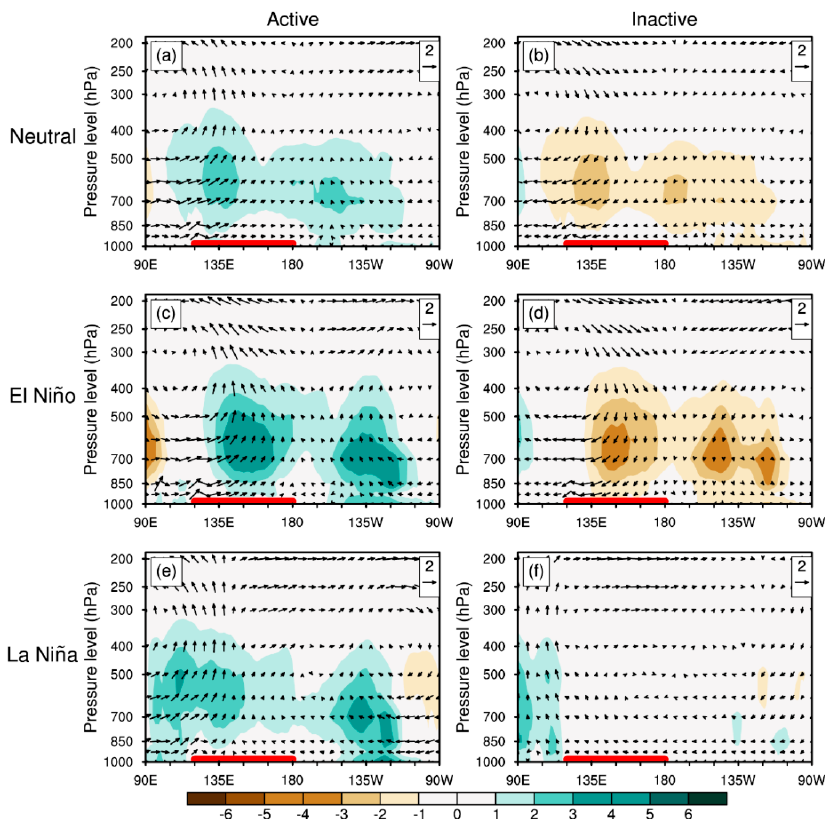
Figure 11. Composite longitude-height section of filtered wind anomalies (vectors; unit: m·s − 1 ) and filtered specific humidity anomalies (shaded; unit: 10 − 1 g·kg − 1 ) averaged over 5° N–20° N in the (left) active and (right) inactive MJO phases for ( a , b ) neutral, ( c , d ) the El Niño, and ( e , f ) the La Niña years during June–November over the period of 1979–2016. Thick red line on abscissas, the WNP location. The definition of the active and inactive phases for the MJO-related WNP TC genesis under different ENSO conditions is in Table 1.